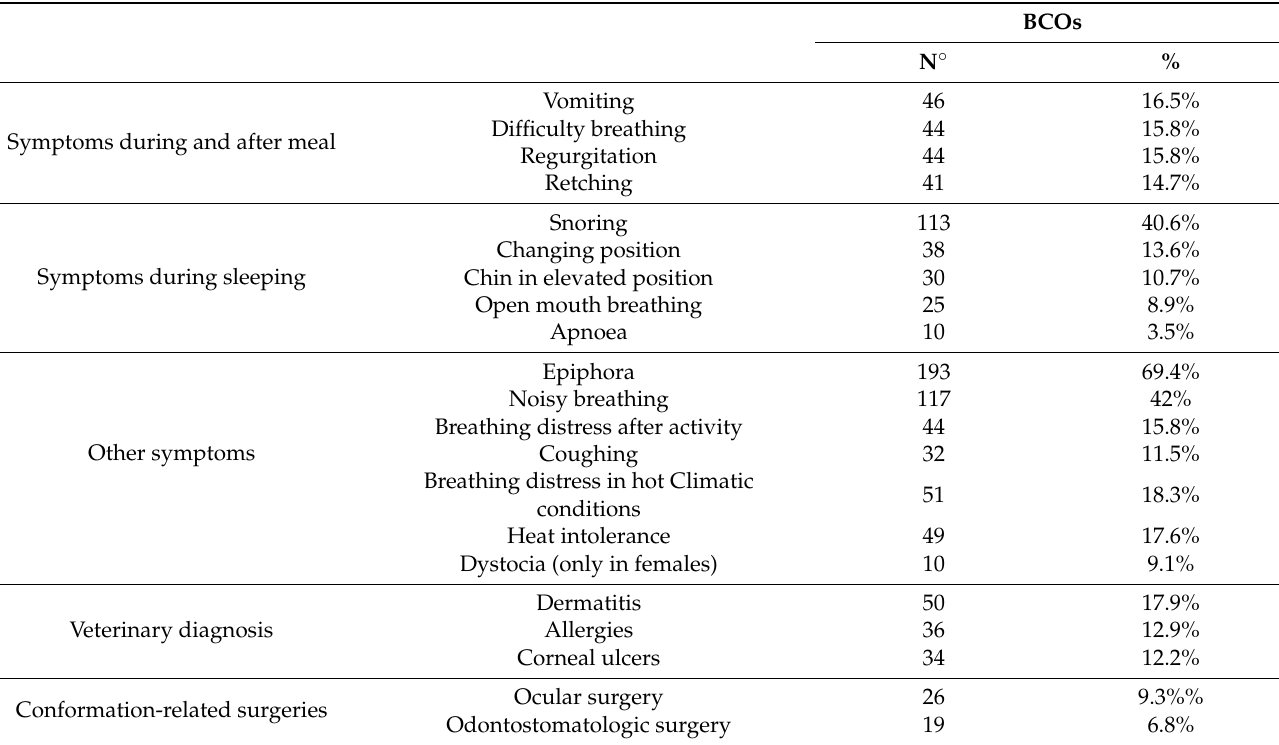
Figure 2. Comparison of emotional closeness subscale (EC) means between brachycephalic and non- brachycephalic breeds. Dots represent weak outliers. Figure 3. Comparison of perceived cost subscale (PC) means between brachycephalic and non- brachycephalic breeds. Dots represent weak outliers; stars represent strong outliers. Breed was associated with the EC, COI, and PC subscale scores in the linear regres- sion ( p ≤ 0.05); family members were associated only with COI, and veterinary routine resulted in being associated with PC ( p ≤ 0.05). For the subscale PC, the overall regression was statistically significant (R 2 = 0.28, F = 2.518, p = 0.021). For the subscale EC, the overall regression was statistically significant (R 2 = 0.68, F = 2.884, p = 0.000). For the subscale COI, the overall regression was statistically significant (R 2 = 0.50, F= 2.249, p = 0.009). Analysing only brachycephalic breeds, we found that the age of the cat was associ- ated with EC subscale scores and the source of adoption with PC subscale scores in the